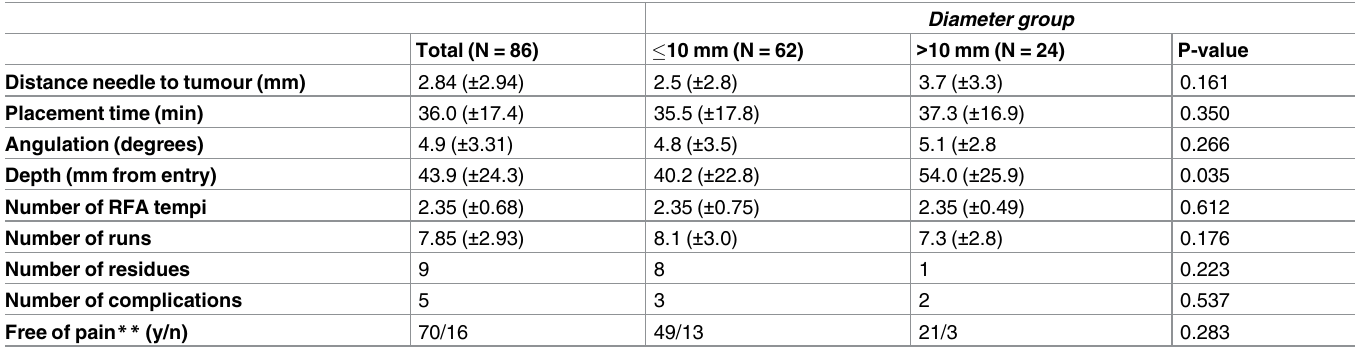
Table 2. Population separated in groups based on tumour